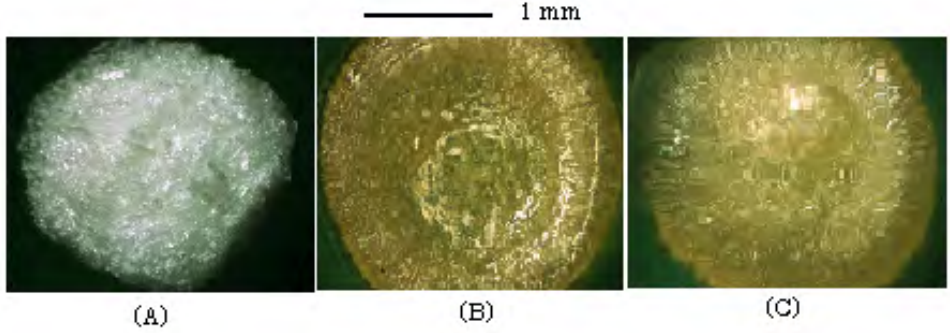
Figure 2. Photograph of dried